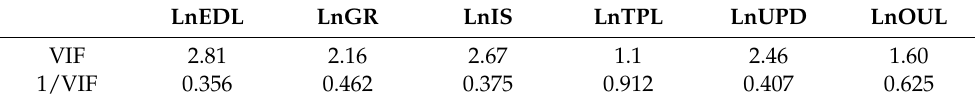
Table 9. The VIF